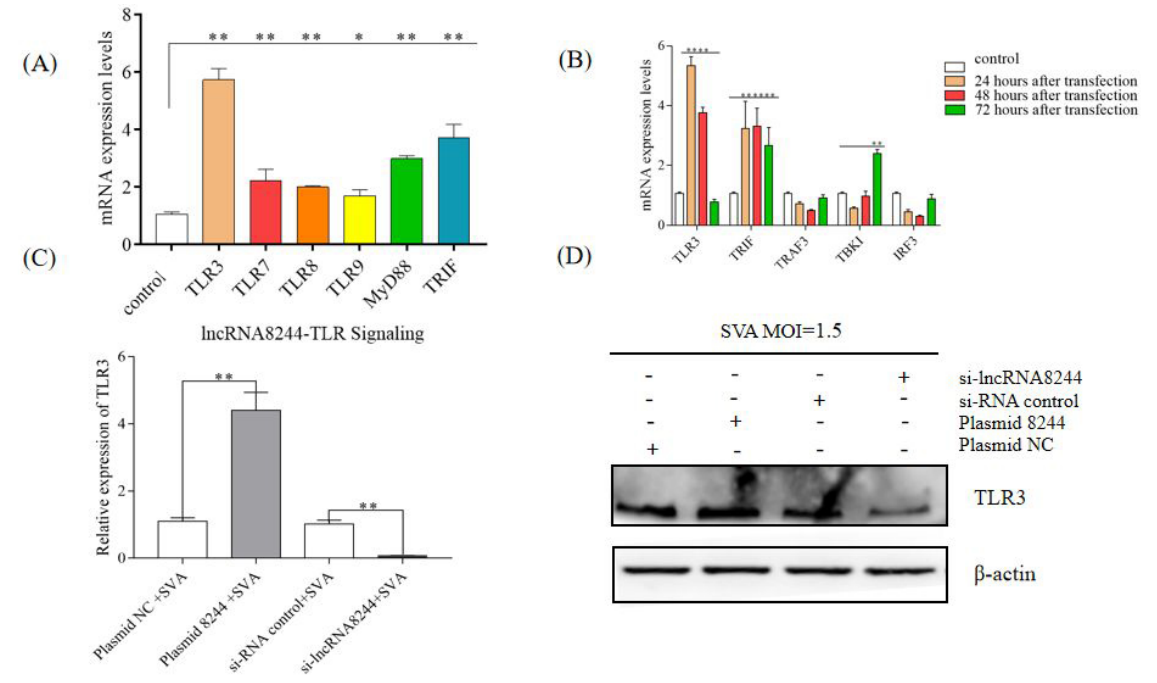
Figure 3. LncRNA 8244 can up-regulate the expression of key molecules in the TLR signaling pathway. ( A ) The expression of TLR3/TLR7/TLR8/TLR9/MyD88/TRIF. ( B ) The expression level of TLR3/TRIF/TRAF3/TBK1 and IRF3 was normalized to the mRNA level of GAPDH. ( C ) The expres- sion level of TLR3 was determined by real-time RT-PCR assay or Western blot ( D ). The mRNA level of TLR3 was normalized to the mRNA level of GAPDH, and anti- βactin was used as a control for Western blot sample loading. All data are represented as mean ± SD with three replicates. * p < 0.05; ** p < 0.01.